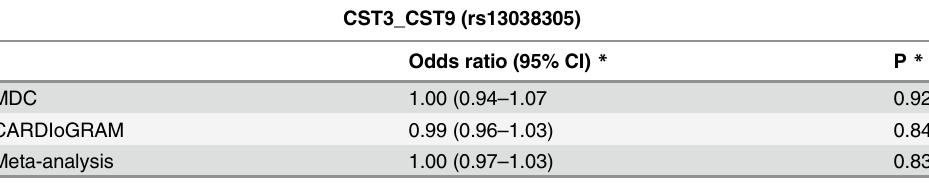
Table 3. Risk of coronary artery disease (CAD) according to rs13038305 in MDC, CARDIoGRAM and the pooled data as a